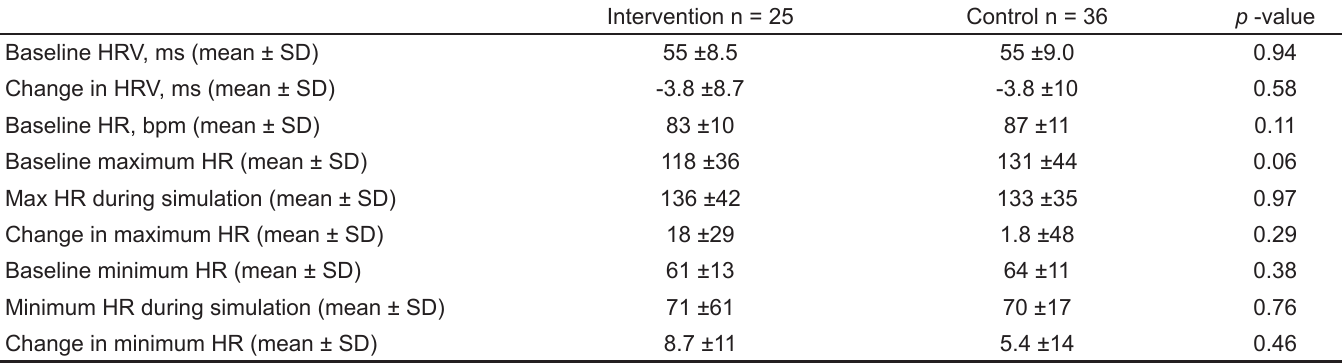
Table 3. Comparison of mean biometric data between control and intervention groups.